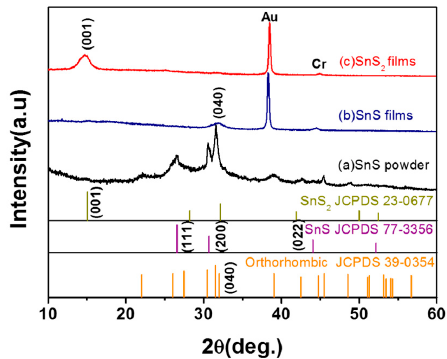
Figure 1. XRD pattern for: ( a ) SnS nanocrystals; ( b ) SnS thin film; and ( c ) SnS 2 thin film.